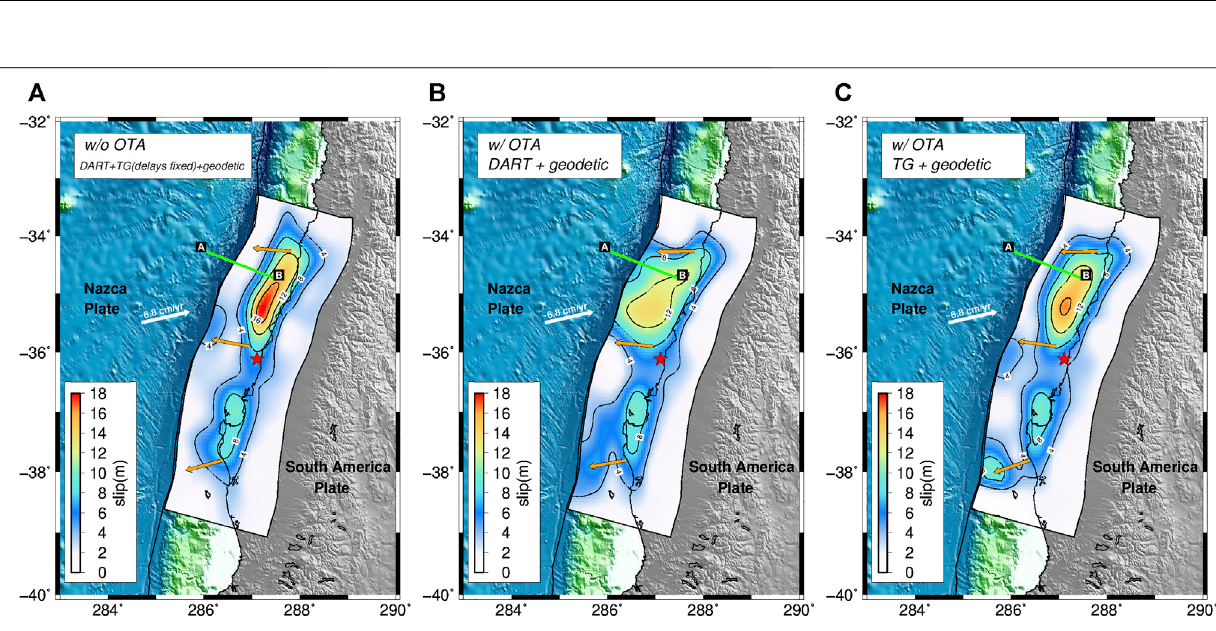
Frontiers in Earth Science |